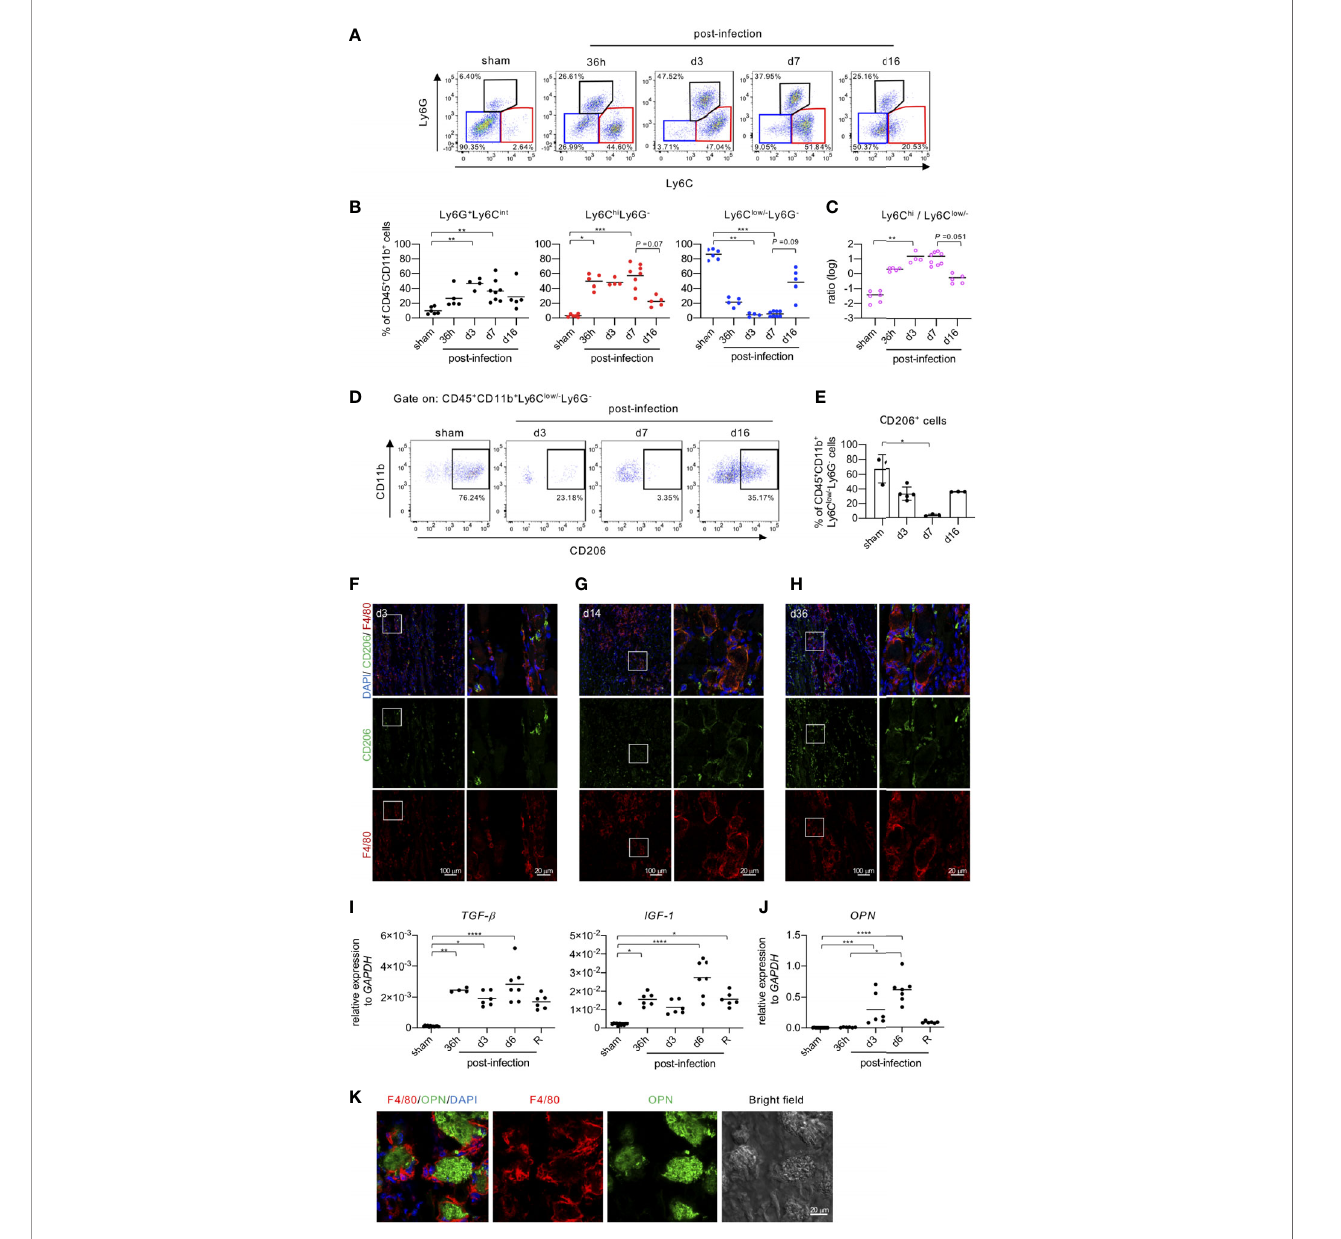
FIGURE 3 | Macrophage phenotypes change in accordance with EV71-induced myositis and muscle regeneration. (A-C) FACS analysis of myeloid populations in muscle tissues. EV71-infected mice were sacri fi ced on the indicated day post-infection. Cells isolated from hindlimb muscles (gastrocnemius and soleus) were subjected to surface staining for CD45, CD11b, Ly6C, Ly6G and intracellular staining for CD206. Live single muscle cells were fi rst gated on myeloid cells (CD45 + CD11b + ) followed by further gating on neutrophils (Ly6G + Ly6C int ), monocytes/in fl ammatory macrophages (Ly6C + Ly6G - ) and anti-in fl ammatory/restorative macrophages (Ly6C low/- Ly6G - ). Representative pseudo-color plots are shown (A) . The frequencies of myeloid populations in muscles of EV71-infected mice are shown (B) . The ratio of in fl ammatory macrophages to anti-in fl ammatory/restorative macrophages is shown (C) . Each symbol represents one mouse. (D, E) FACS analysis of CD206 expression in anti-in fl ammatory/restorative macrophages (CD45 + CD11b + Ly6C low/- Ly6G - ). Representative pseudo-color plots (D) and the frequencies (E) are shown. Each symbol represents one mouse (n = 3-5). (F-H) Cryosections of gastrocnemius muscle in representative EV71-infected mice at day 3 (score = 2) (F) , day 14 (score = 1) (G) , and day 36 (score = 0) (H) post-infection were immunostained for CD206 (green) and F4/80 (red). The indicated regions from the left panels are shown magni fi ed in the right panels. The relative gene expression levels of TGF- b , IGF-1 (I) and OPN (J) in gastrocnemius and soleus muscle of EV71-infected mice were analyzed by real-time quantitative PCR and normalized to GAPDH . Each symbol represents one mouse (n = 4-8). R represents recovery. (K) Sections of gastrocnemius muscle from EV71-infected mice at day 14 post-infection were stained with OPN (green) and F4/80 (red). Images were obtained by LSM700 or LSM880 confocal microscopy. P values in (B, C, I, J) were calculated by Kruskal-Wallis test with Dunn ’ s multiple comparison test. * P < 0.05; ** P < 0.01; *** P < 0.001; **** P <